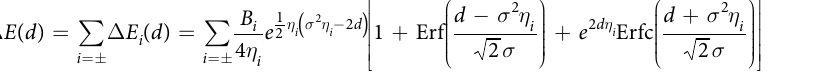
( ) in the ran g e g ∈ [ − 2, 2].